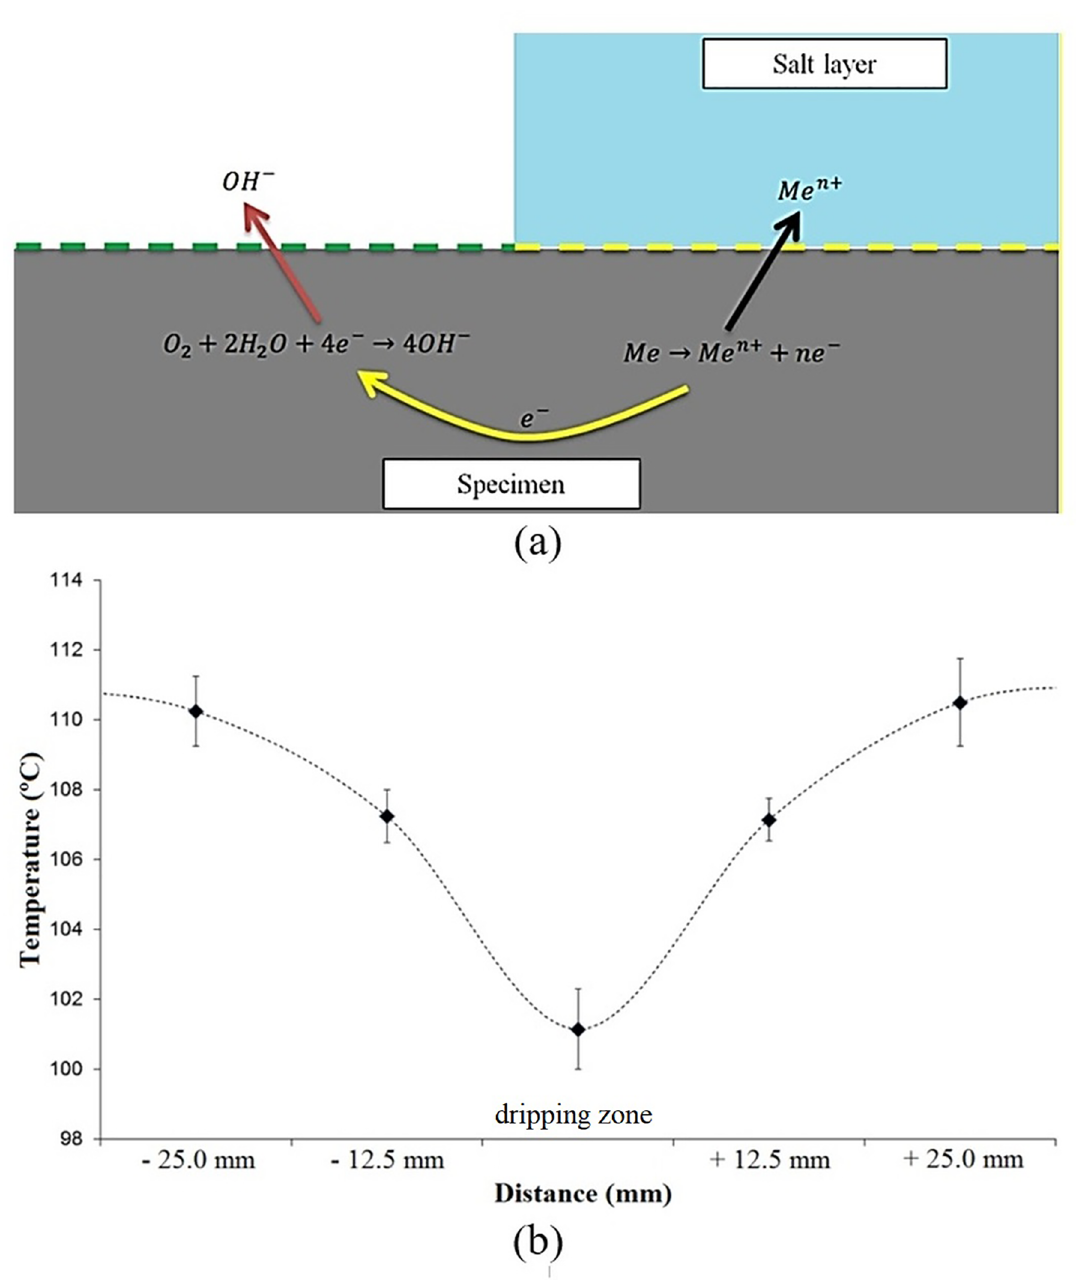
Figure 14. (a) Scheme showing the relative position of the cathodic (dripping zone) and the anodic reactions (under the salt deposit); (b) Temperature distribution along the upper surface of the specimen at 110 ºC. The temperature in the center of the dripping region is roughly 10 ºC lower than the testing temperature. Points located at -25 mm and + 25 mm represent the usual SCC nucleation sites 41 . between the deposit and the surface of the specimens,